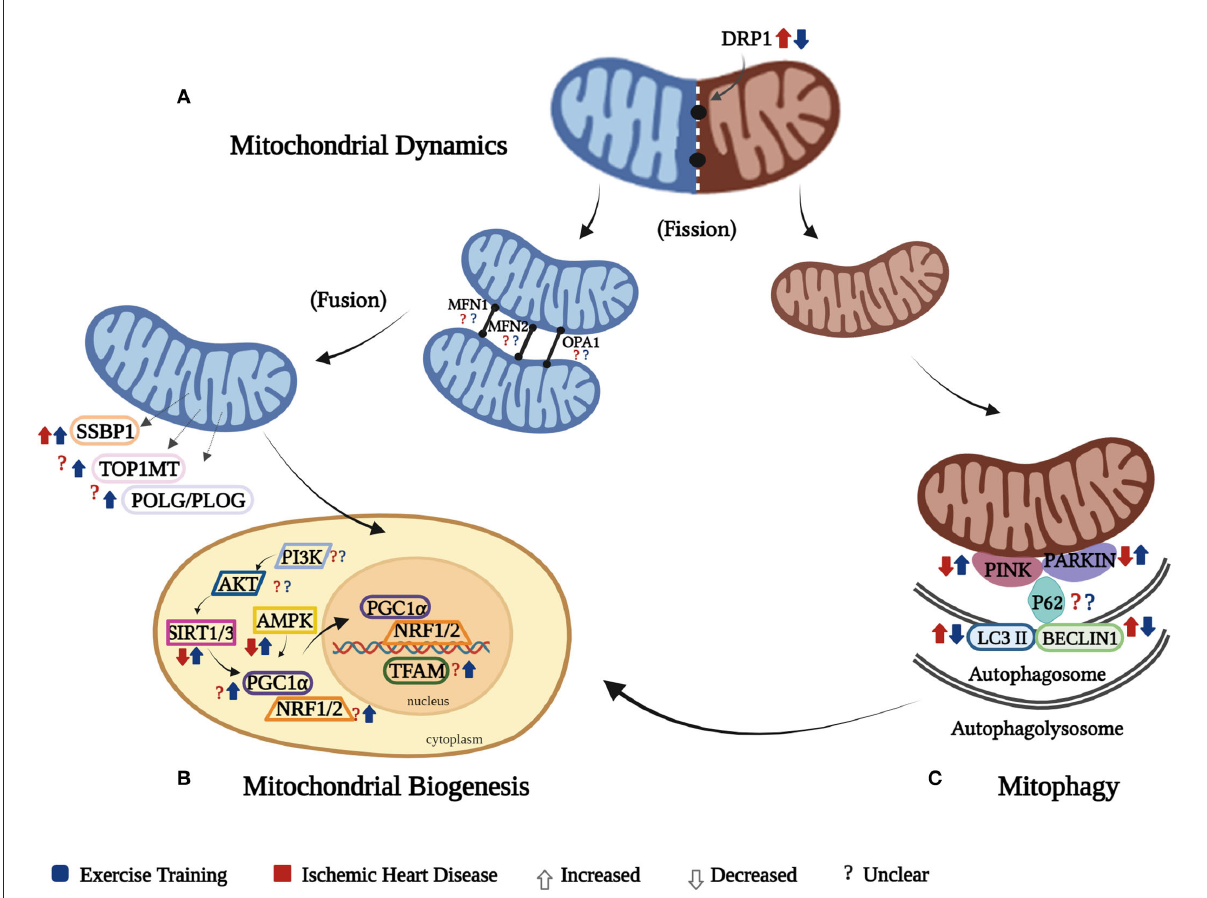
FIGURE3 Cardiac mitochondrial quality control (MQC). The effect of IHD and ET on the cardiac MQC is presented separately through its three components: (A) the mitochondrial dynamics shows increased fission as a result of increased DRP1 in IHD and was reversed by ET, while there was an unclear effect of IHD and ET on cardiac mitochondrial fusion biomarkers (MFN1, MFN2, and OPA1); (B) mitochondrial biogenesis happens in response to the continuous need of energy, but in IHD,this mechanism is impaired as manifested by decreased transcription and translation processes due to diminished expression of SIRT3 and AMPK, which was reversed by ET, while both IHD and ET show unclear effects on AKT, PI3K, PGC1a, NRF1/2, POL/PLOG, TOP1MT. SSBP1, on the contrary, was increased in IHD and ET further increased it. Of note, PGC-1 α is the key regulator in mitochondrial biogenesis, which might be triggered by SIRT1 or 3 and AMPK. The activated PGC-1 α might not only enhance expression of the NRF1/2 to result in nuclear-encoded mitochondrial proteins, but also directly activate TFAM, which in turn to promote the transcription of mitochondria gene-encoded proteins in mitochondria; (C) mitophagy happens secondary to damaged mitochondria, which in IHD this mechanism is disrupted as manifested by decreased in PINK and Parkin, which were ameliorated by ET, while there is an unclear effect of both IHD and ET on P62. The autophagosomal factors, LC3II and Beclin 1, were increased in IHD, whereas ET attenuated their levels. As there is a continuous removal of mitochondria, and the process of mitophagy progresses on the autophagolysosomal level, it triggers the different mitochondrial biogenesis biomarkers to function in order to form new mitochondria. It should be noted that these three components work together, and affect the mitochondrial